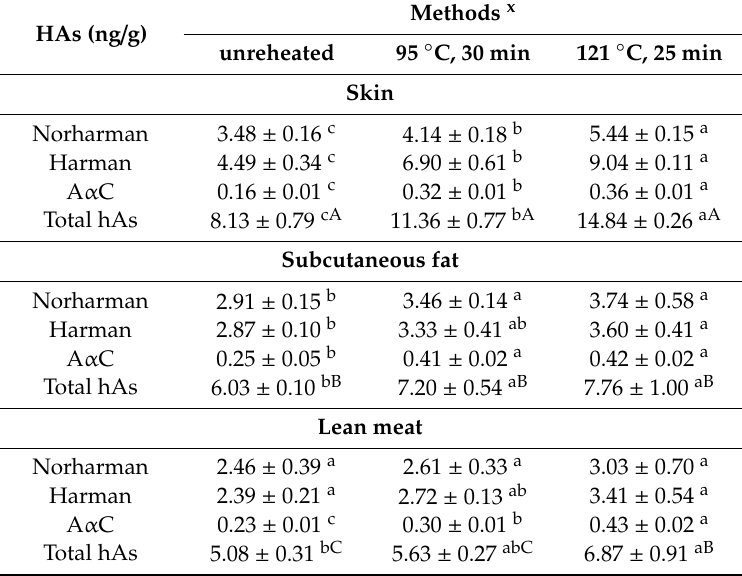
Table 4. E ff ect of reheating on the formation of heterocyclic amines (HAs) in the marinated pig hock skin, subcutaneous fat, and lean